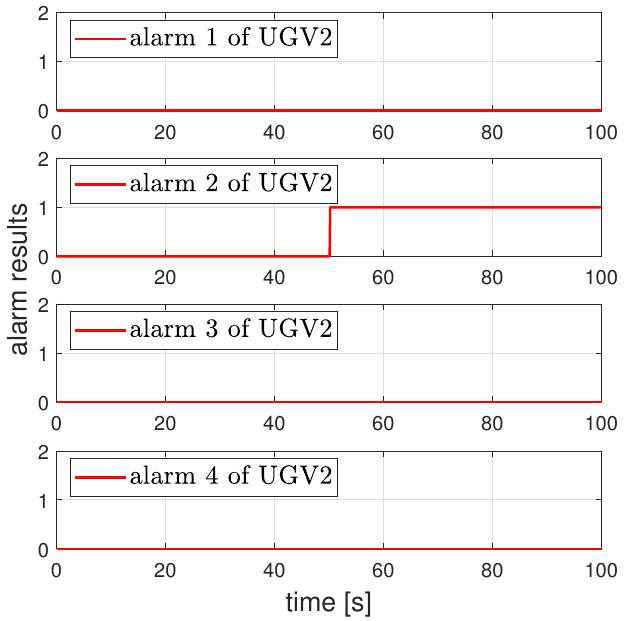
Figure 10. Fault isolation of UGV2. A value of one indicates an actuator fault and the value of zero indicates normal operation.